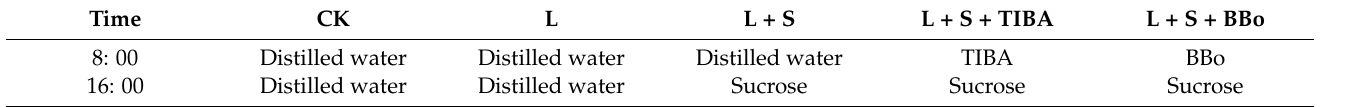
Table 1. Treatment methods for exogenous sucrose and IAA